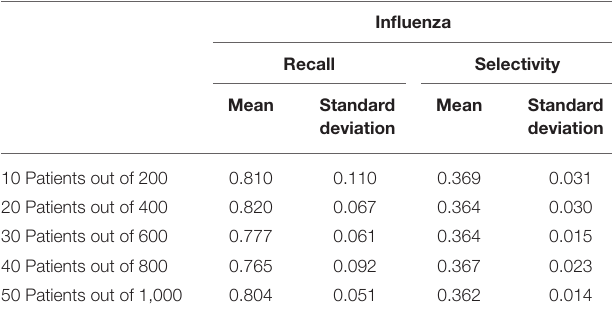
TABLE 2 | Recall and selectivity of linking cough as a first symptom of patients with